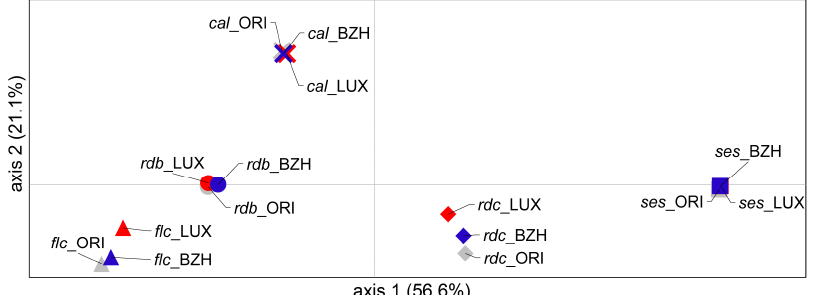
Figure 3. Two-dimensional plot of the principal coordinate analysis (PCoA) showing the clustering of the studied populations. Different symbols refer to different varieties. ORI populations are represented in grey, LUX in red and BZH in blue.